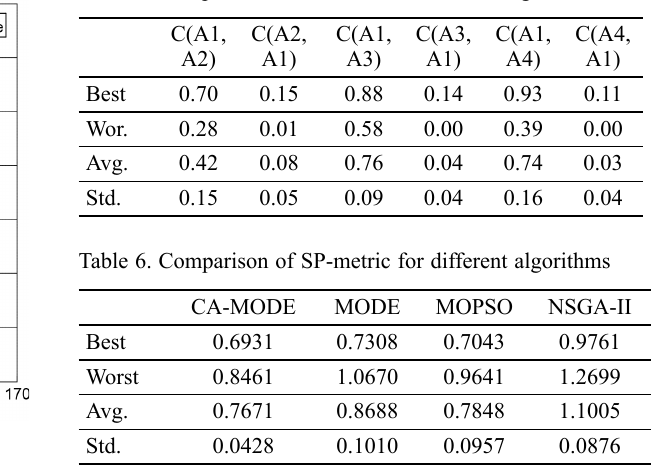
Table 5. Comparison of C-metric for different algorithms